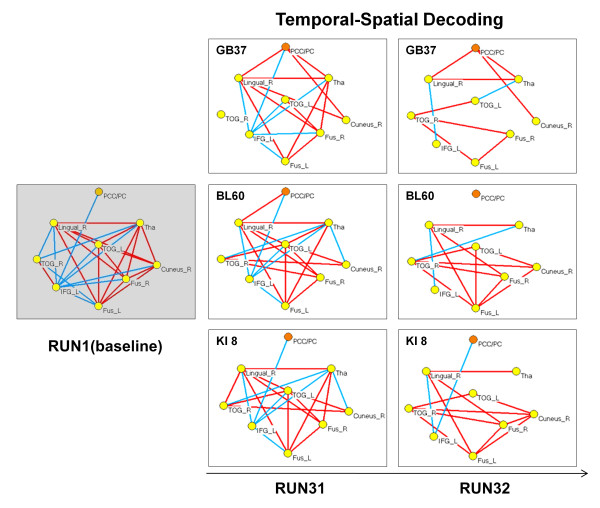
The results from graphic theory-based CNA (see Methods), showing the topological and functional maps of the visual RSN (consisting of the yellow nodes) and its dynamic interactions with the PCC/pC (the red node) as a system encoding/decoding hub with respect to three different acupoints (two visual acupoints: GB37 and BL60, and a non-visual acupoint KI 8). The red lines referred to the significant (p < 0.05, see the Methods for details) positive functional connections among the visual function-related network, and the blue lines the significant negative connections.